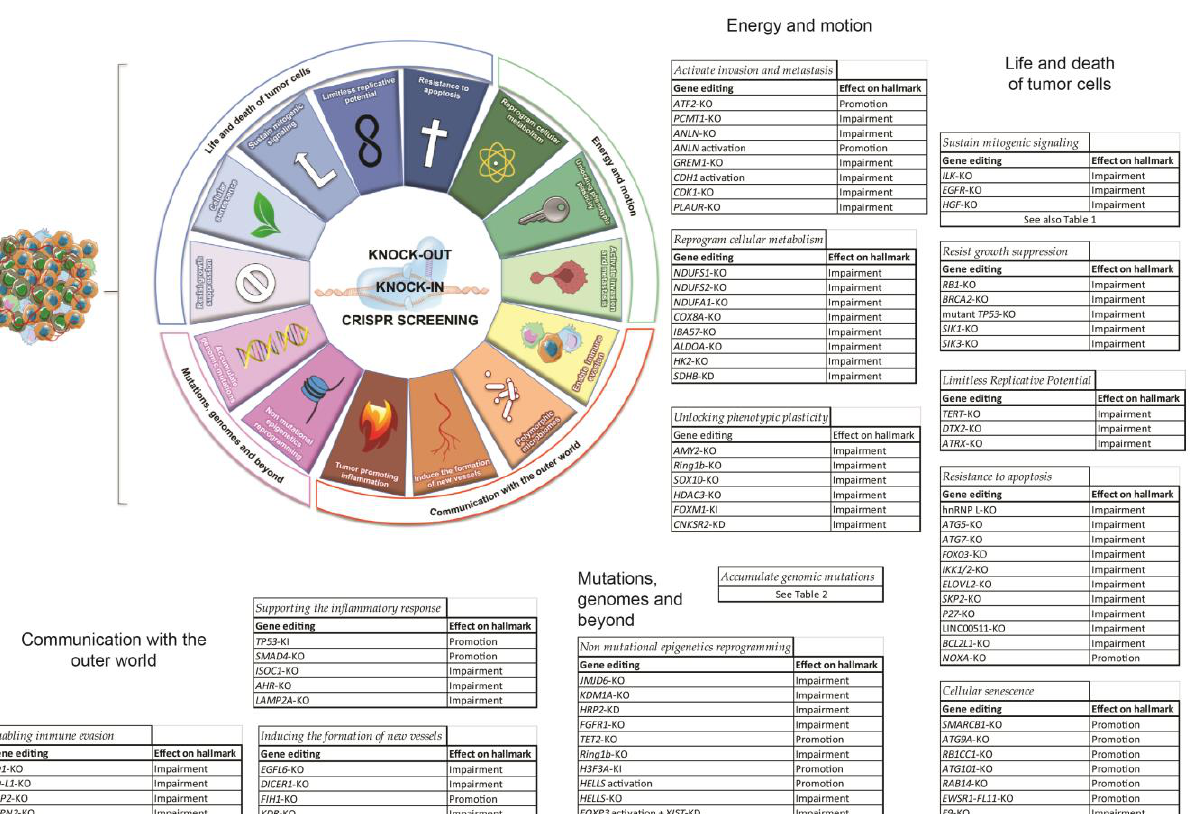
Figure 1. Classic representation of cancer hallmarks according to Hanahan’s latest review (2022). Surrounding the graphic, tables listing the genome editing targets described in the corresponding section and the effect they had in vitro according to the corresponding hallmark.